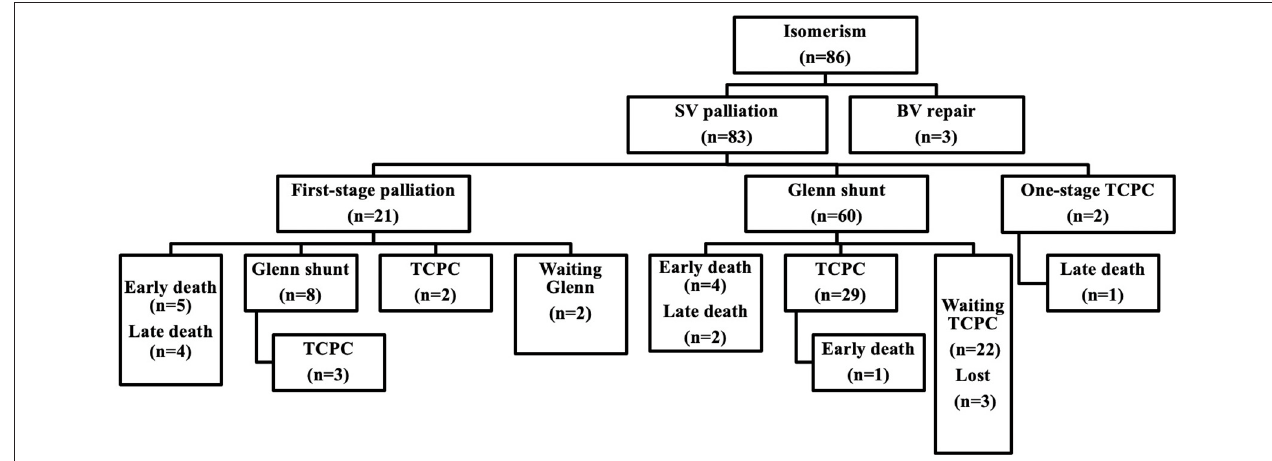
FIGURE 1 | Flow chart of interventions in 86 patients with atrial isomerism.